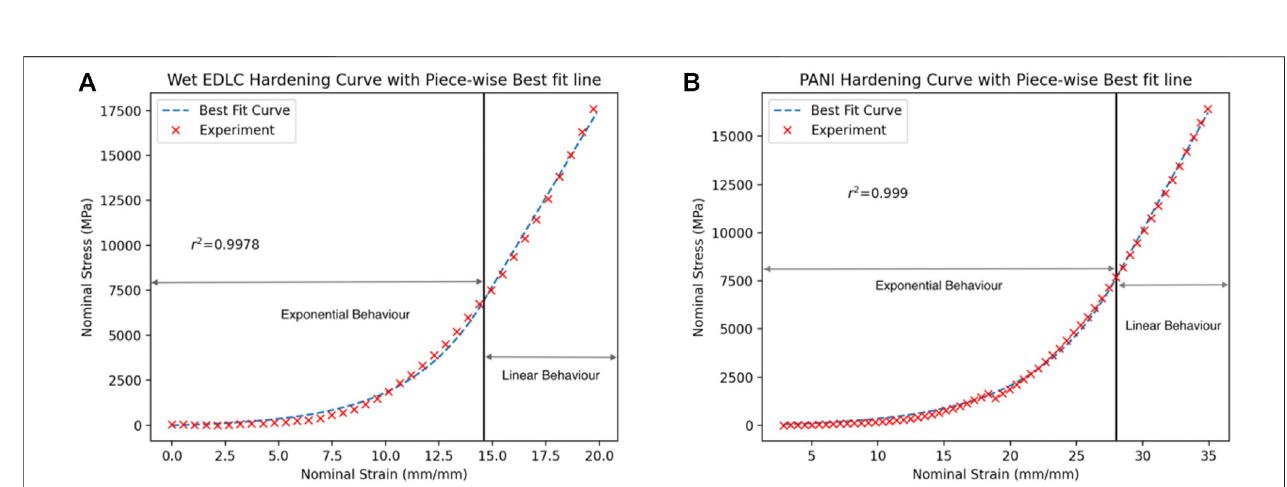
FIGUREA1 |(A) Best fi t curve for thehardeningregion ofthe DryCell 1EDLC nailpenetration (B) Best fi tcurve for thehardening region ofthePANI-1, CNT/PANI- coated pseudocapacitor nail penetration.